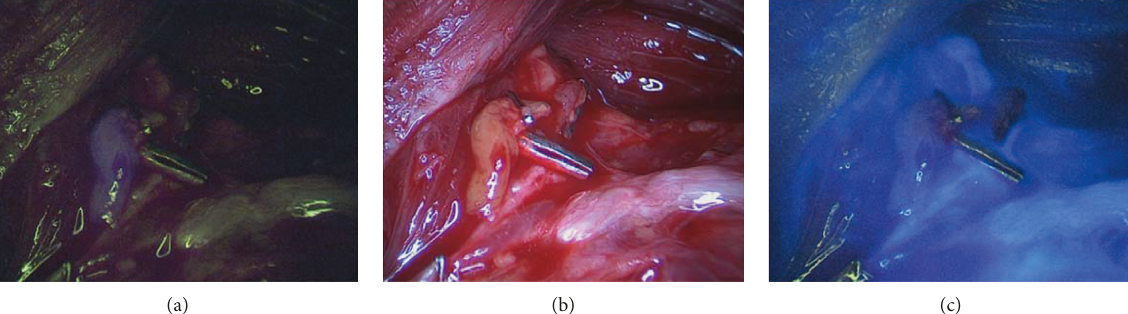
Figure 1: Parathyroid gland. (a) Autofluorescence image that displays the typical bluish violet color of the gland. (b) The parathyroid gland in normal white light. (c) 2min after i.v. application of 5mg ICG. The gland shows hardly any ICG fluorescence, and it can be assumed that it is devascularized. Table 2: Comparison of autofluorescence (AF) and indocyanine green (ICG) fluorescence. AF positive AF negative Total ICG positive 56 63 ICG negative 8 (4 devas.) 15 Total 64 14